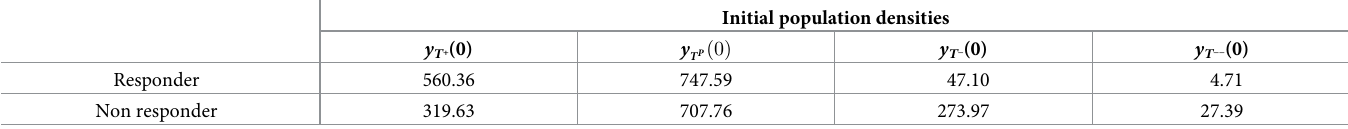
Table 3. The initial population densities